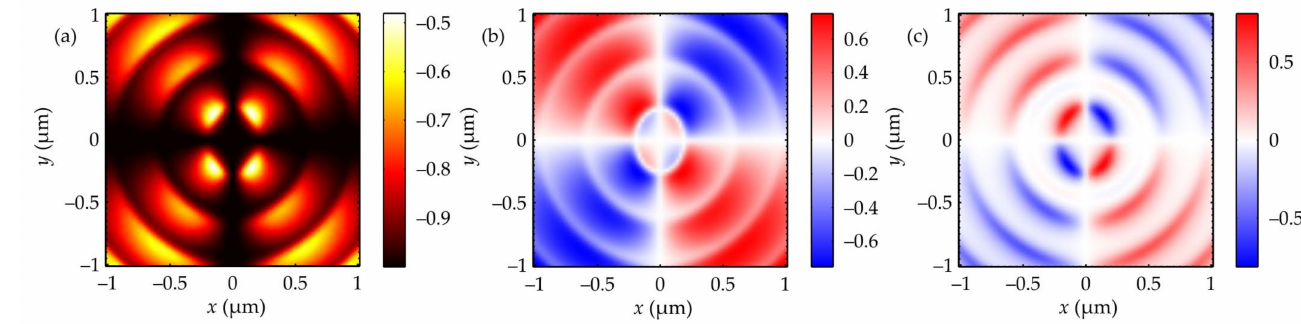
Figure 6. Distribution of the components of the normalized Stokes vector S 1 ( a ), S 2 ( b ) and S 3 ( c ) at a distance λ before the focal